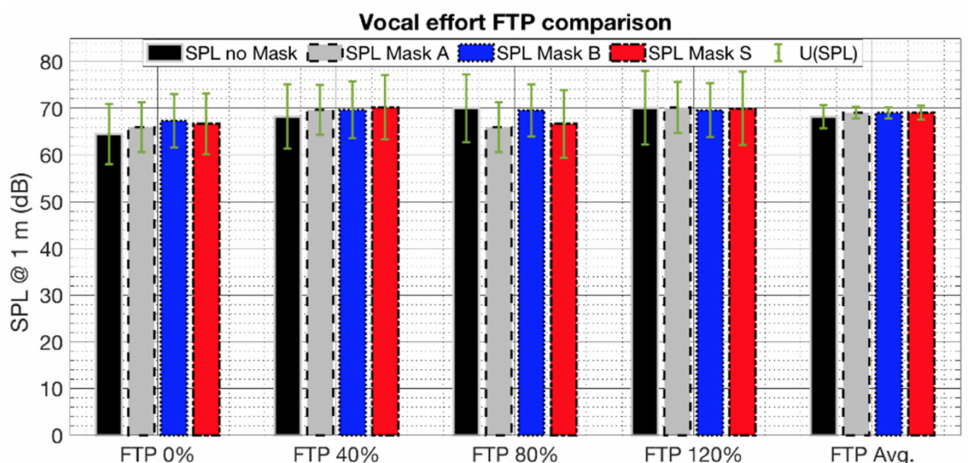
Figure 7. Averaged sound pressure levels at 1 m from the mouth (SPL@1 m) for different mask conditions, reported as averages over the three subjects for the four efforts (FTP at 0%, 40%, 80%, 120%) and as overall (FTP Avg).